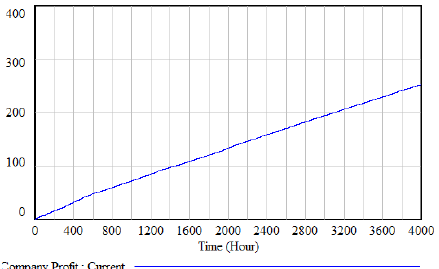
Fig. 3. Company profit after 300 hours